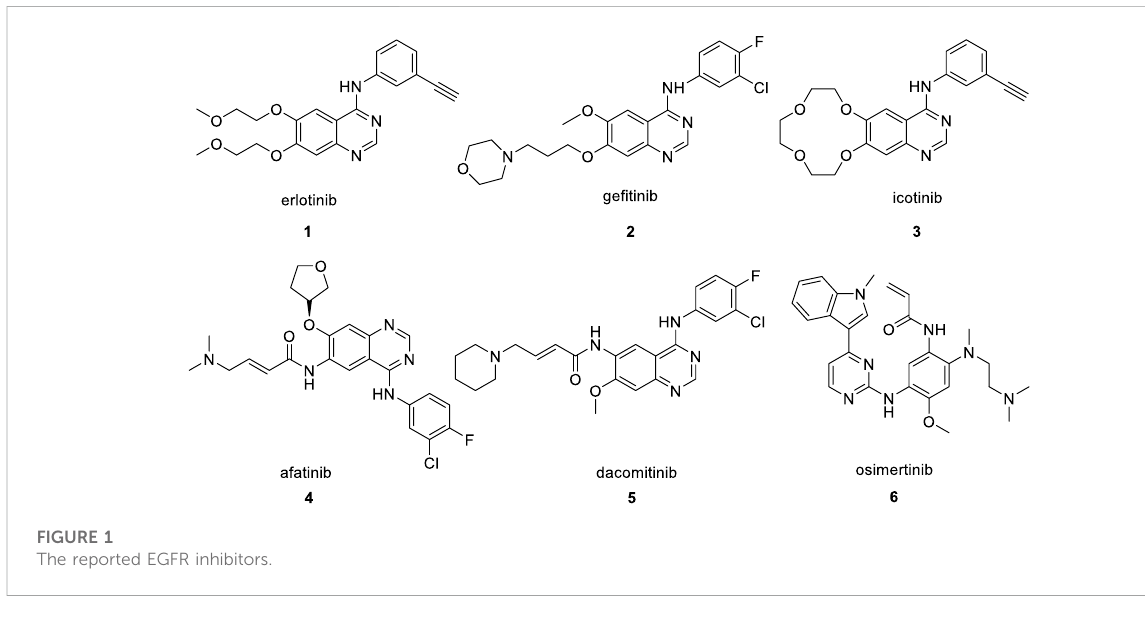
FIGURE 1 The reported EGFR inhibitors.